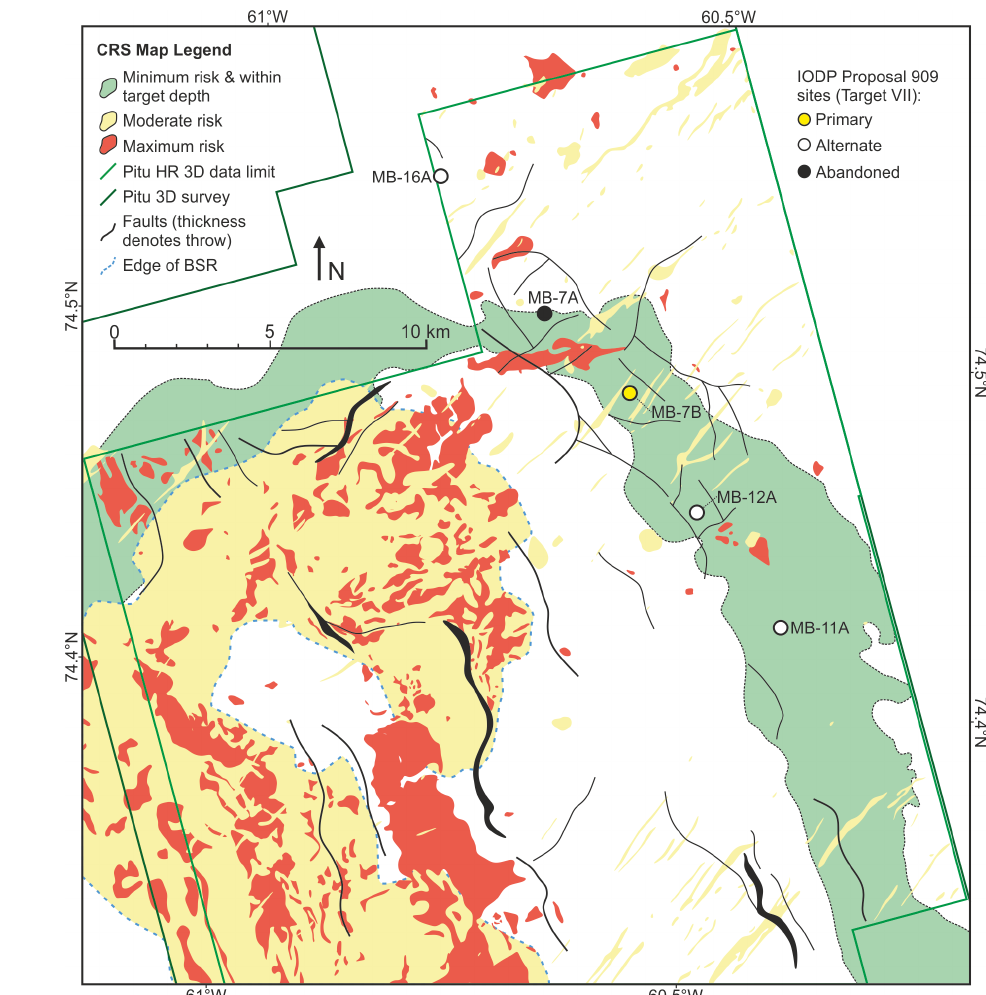
Figure 10. A common risk segment (CRS) map showing the green, minimum risk, depth target zone for Target VII where sites can be located safely whilst meeting the stratigraphic objectives. This CRS map was used to guide the site selection and abandonment of the shown Target VII sites. Similar CRS maps were also created to guide site selection and abandonment for the other stratigraphic targets within 3D seismic coverage (Targets